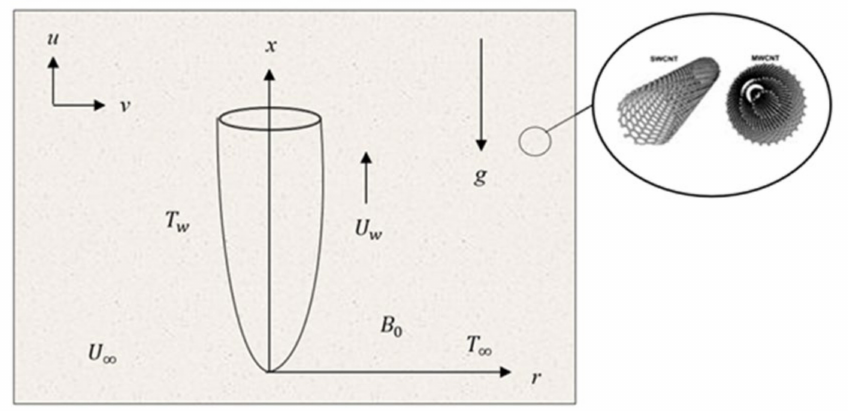
Figure 1. Model of physical geometry.